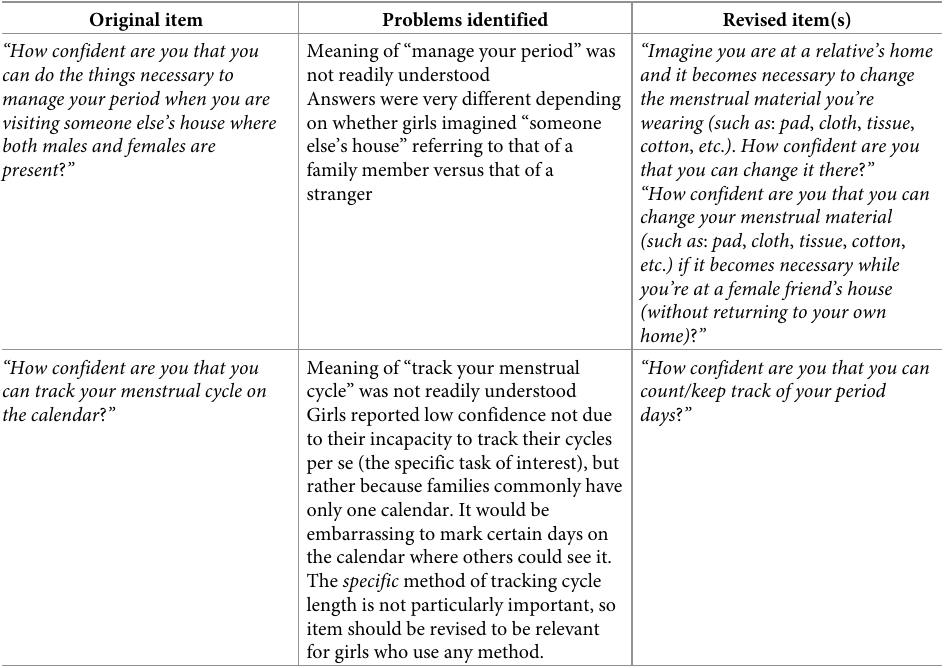
Table 1. Example item revisions based on findings from cognitive interviews with schoolgirls during the develop- ment of the Self-Efficacy in Addressing Menstrual Needs Scale in Bangladesh,